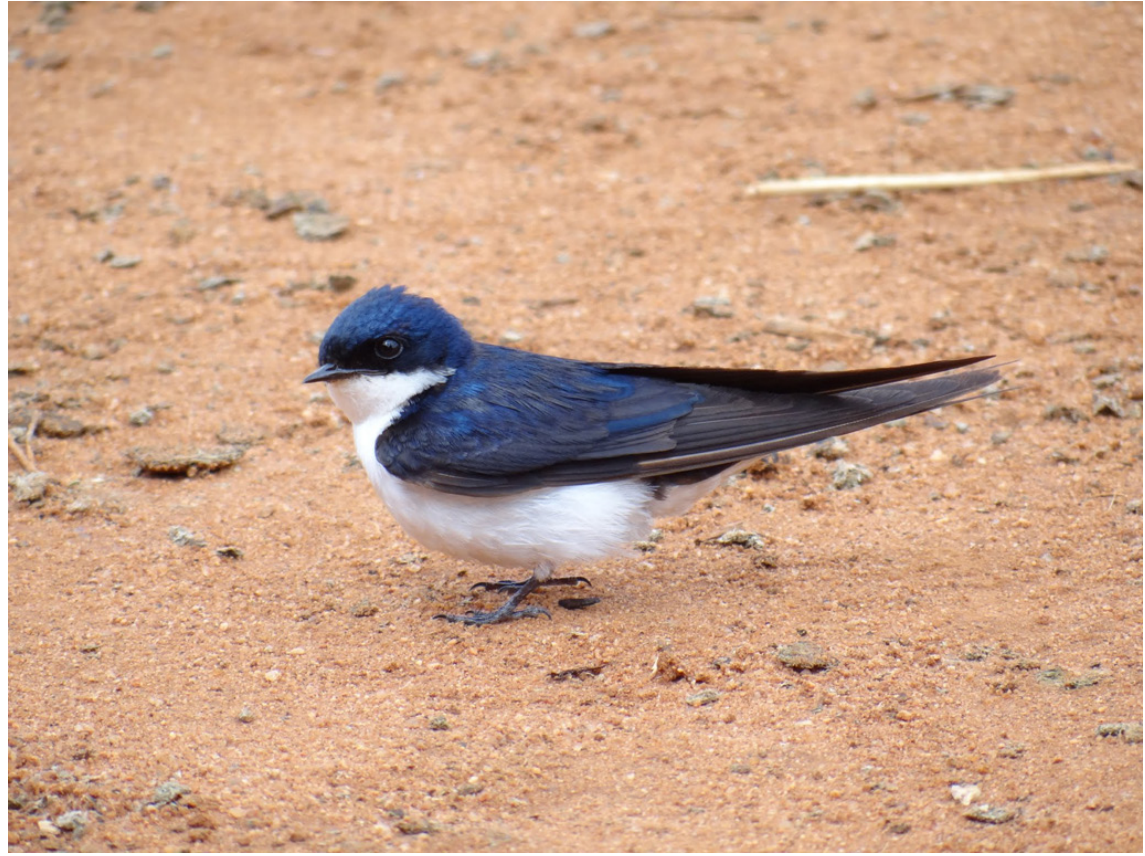
Fig. 6. The White-tailed Swallow Hirundo megaensis Benson, 1942 is another endemic species to Oromia, restricted to the Borana and Guji zone (Photo: Kai